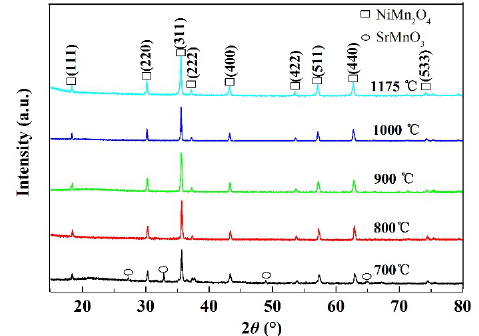
Fig. 1 Schematic illustration of (a) thermal shock equipment and (b) temperature-cycling profile.